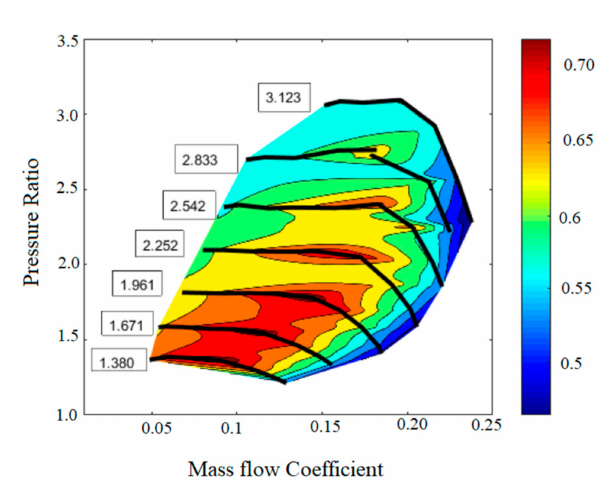
Figure 7. Compressor dimensionless map.